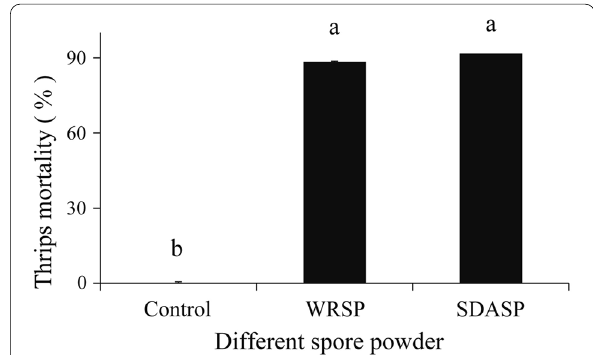
Fig. 5 The mortality (mean SE) of thrips caused by the spore ± powder from white rice and SDA solid media after inoculation 4 days. WRSP: white rice spore powder; SDASP: SDA spore powder. The bars marked with the same letter are not significantly different according to Tukey’ test at P < 0.05. Bars with different letters are significantly different